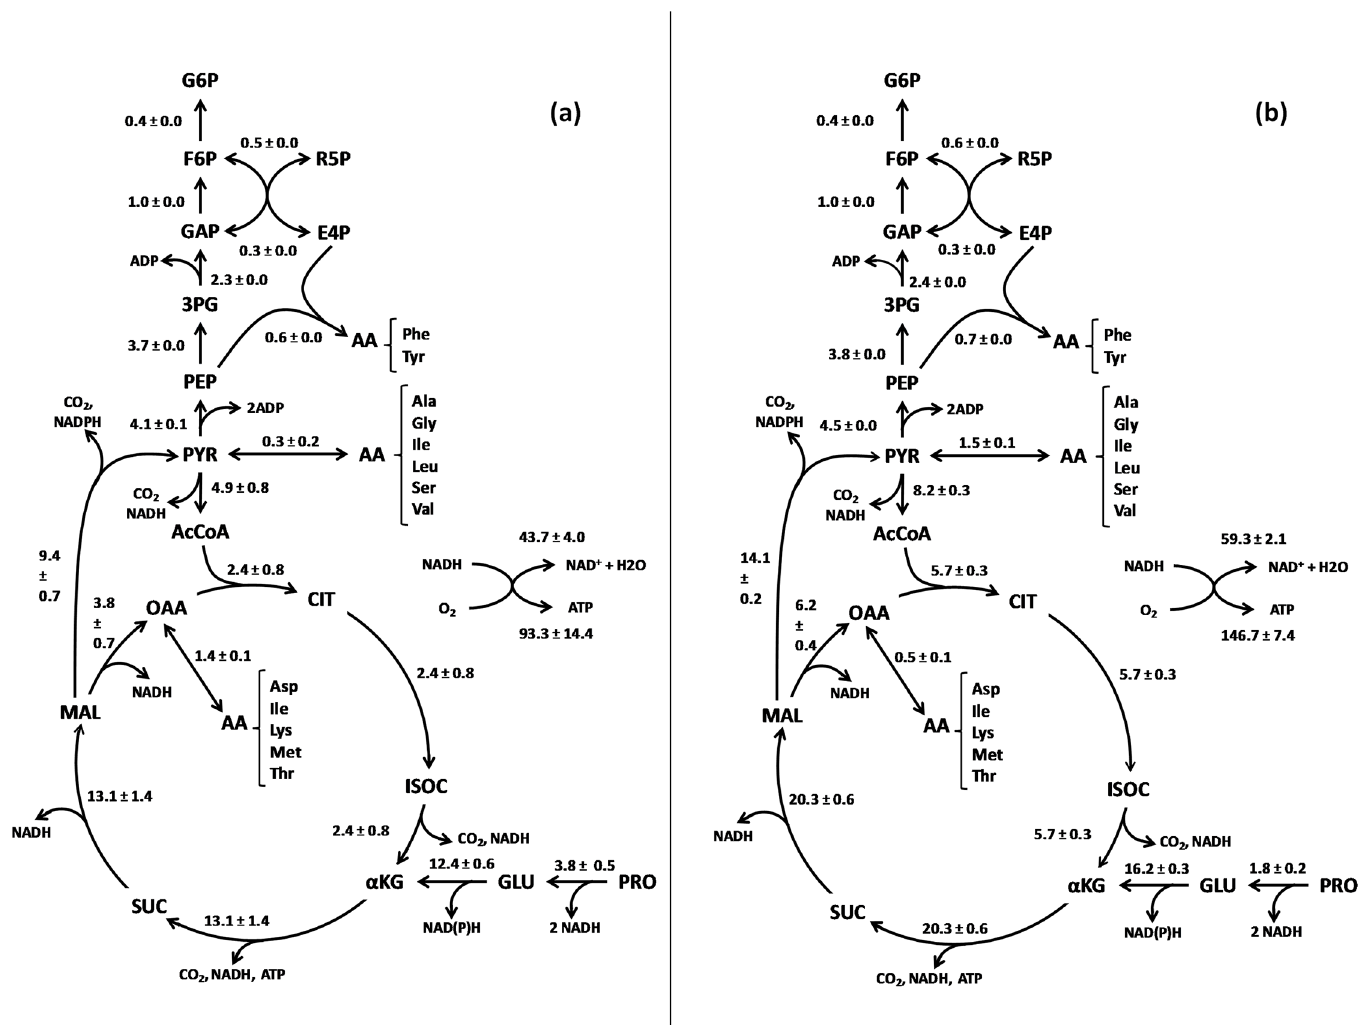
Fig 3. Estimation of carbon distribution within the central metabolic pathways based on the kinetic data from three biological replicates of B . pertussis Tohama I batch cultures. (a) Growth period: 0 – 12h; (b) Growth period: 12h-end of culture. G6P: glucose-6-phosphate; F6P: fructose- 6-phosphate; R5P: ribulose-5-phosphate; E4P: erythrose-4-phosphate; GAP: glyceraldehyde-3-phosphate; 3PG: 3-phosphoglycerate; PEP: phosphoenolpyruvate; PYR: pyruvate; AcCoA: acetyl-CoA; CIT: citrate, ISOC: isocitrate; α KG: α -ketoglutarate; SUC: succinate; MAL: malate; OAA: oxaloacetate; GLU: glutamate; PRO: proline; AA: amino acids; Phe: phenylalanine, Tyr: tyrosine; Ala: alanine; Gly: glycine; Ile: isoleucine; Leu: leucine; Ser: serine; Val: valine; Asp: aspartate; Lys: lysine; Met: methionine; Thr: threonine. Numerical data are reported for the three replicates as mean ± standard deviation. They are expressed in mmoles per liter and per gram of biomass